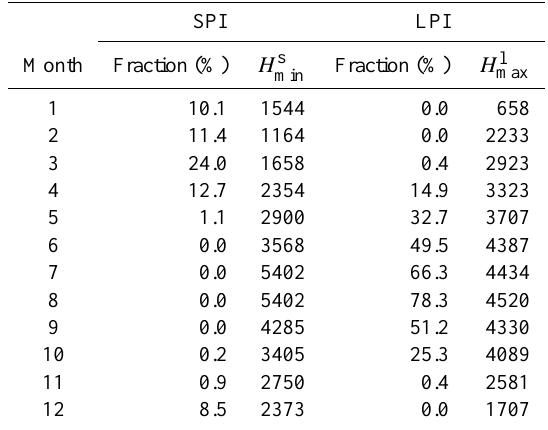
Table 2. Monthly SPI, LPI, H s study region.